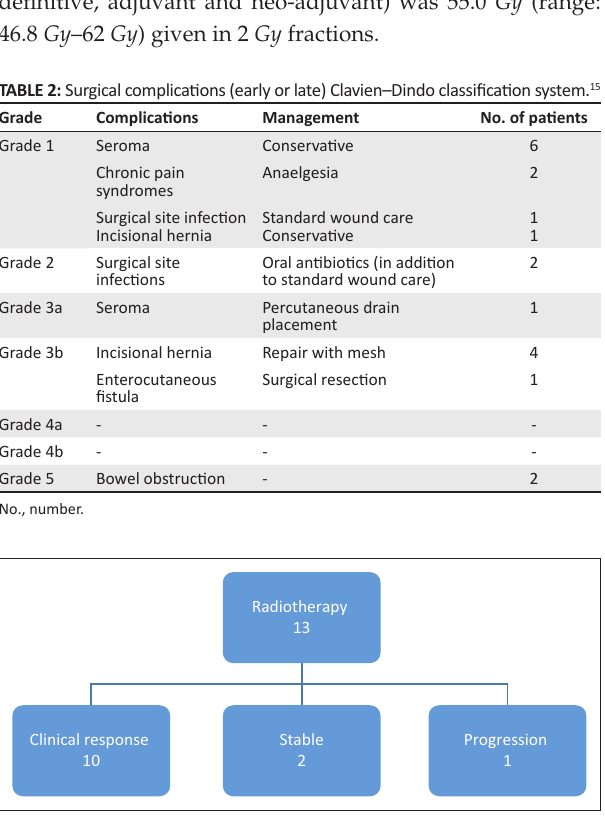
FIGURE 1: Breakdown of definitive treatment modality used. FIGURE 2: Response to definitive radiotherapy treatment .